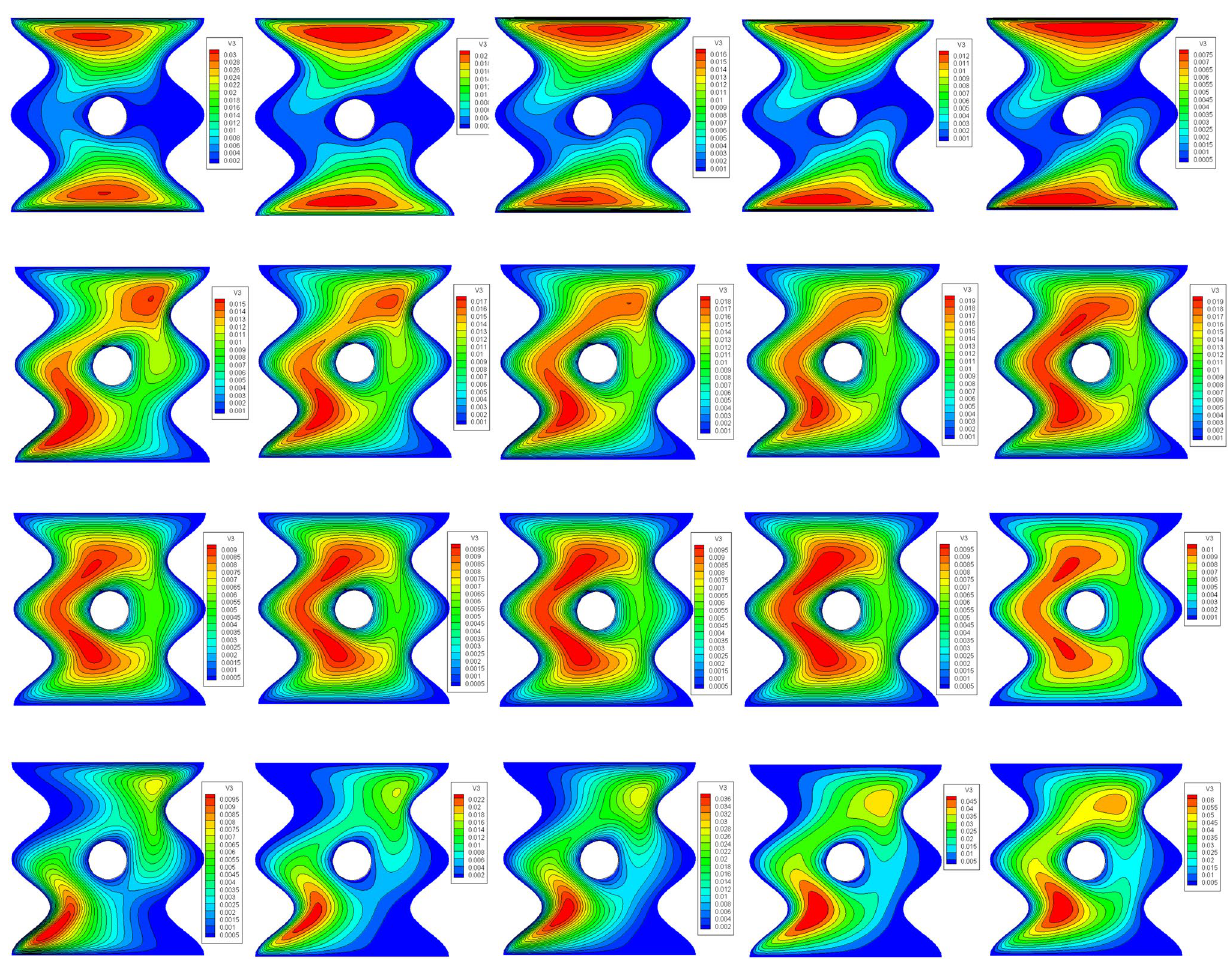
isoconcentrations (4th row), for TiO the moderate values; Q = 1 , Da = 10 – 3 , Ri = 1 , Gr